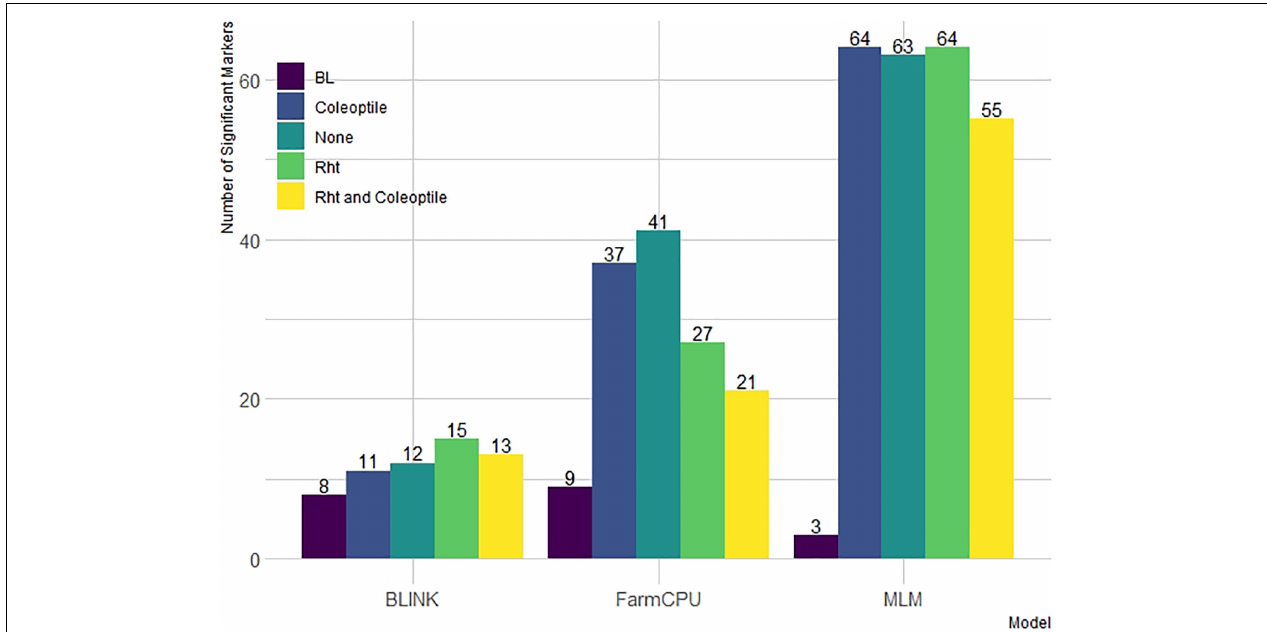
FIGURE 4 | Models compared are Bayesian information and linkage-disequilibrium iteratively nested keyway (BLINK), fixed and random model circulating probability unification (FarmCPU), and mixed-linear model (MLM) with and without Rht and coleoptile length as covariates in the DP and without covariates in the breeding line